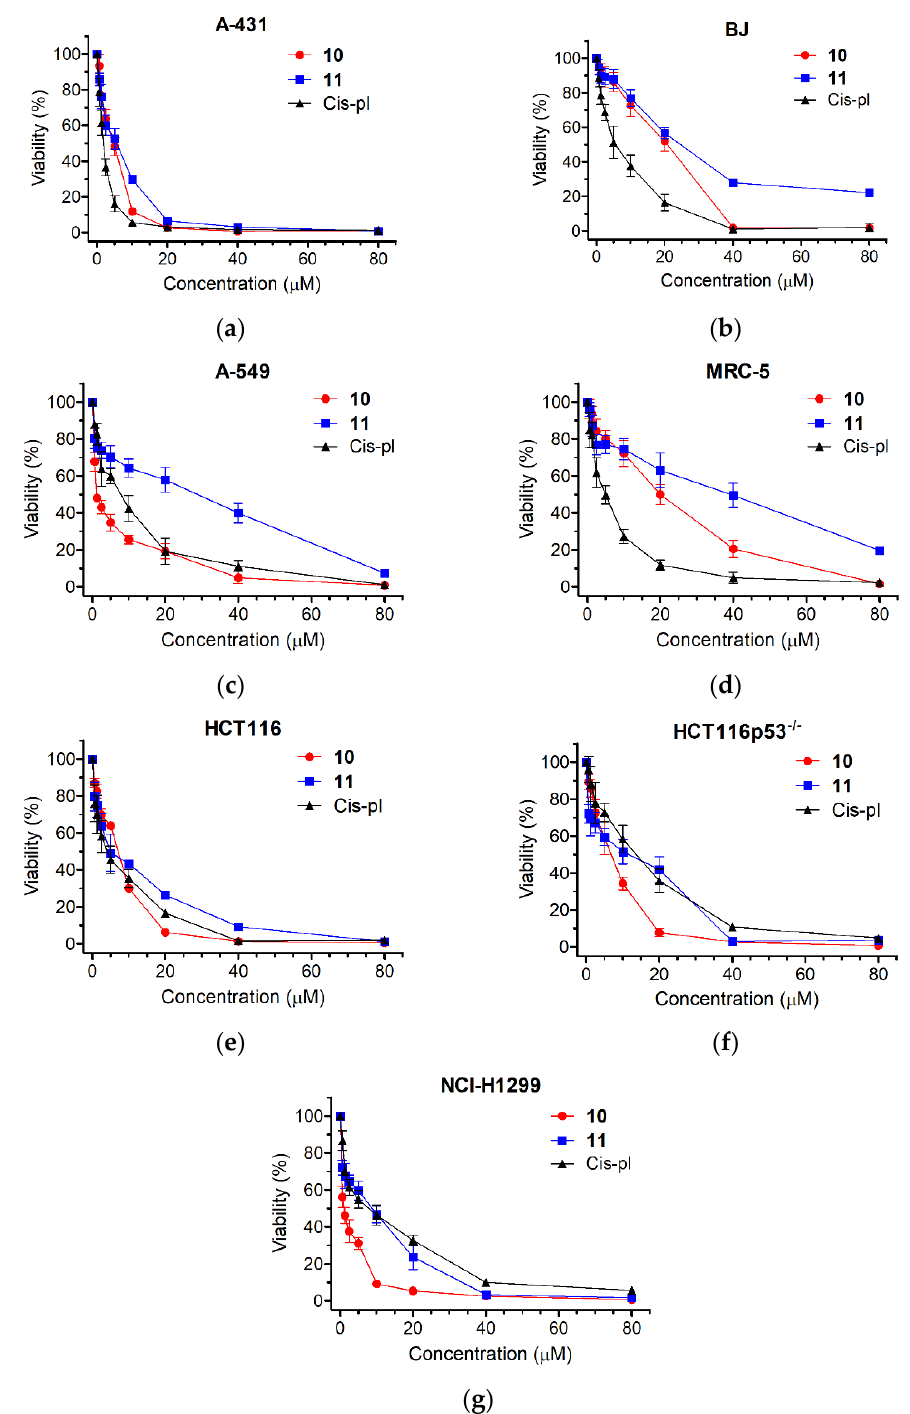
Figure 3. Viability of selected human cell lines in response to compounds 10 , 11 , or cisplatin (cis-pl), evaluated with an MTT assay. The cell lines studied were as follows: ( a ) epidermoid carcinoma A-431, ( b ) normal skin fibroblasts BJ, ( c ) lung carcinoma A549, ( d ) normal lung fibroblasts MRC-5, ( e , f ) colorectal carcinomas HCT116 and HCT116p53 − / − , and ( g ) lung carcinoma NCI-H1299. The cells were incubated with increasing concentrations (range = 0.6–80 µ M) of compounds 10 , 11 , or cis-pl for 72 h. Cisplatin, a well-established DNA damage agent commonly used as a drug in chemotherapy, served as a positive control. The percentage of cell viability inhibition was calculated compared to the untreated cells. Each point on the curves represents the mean ± SD of at least three independent experiments performed in six replicates per drug